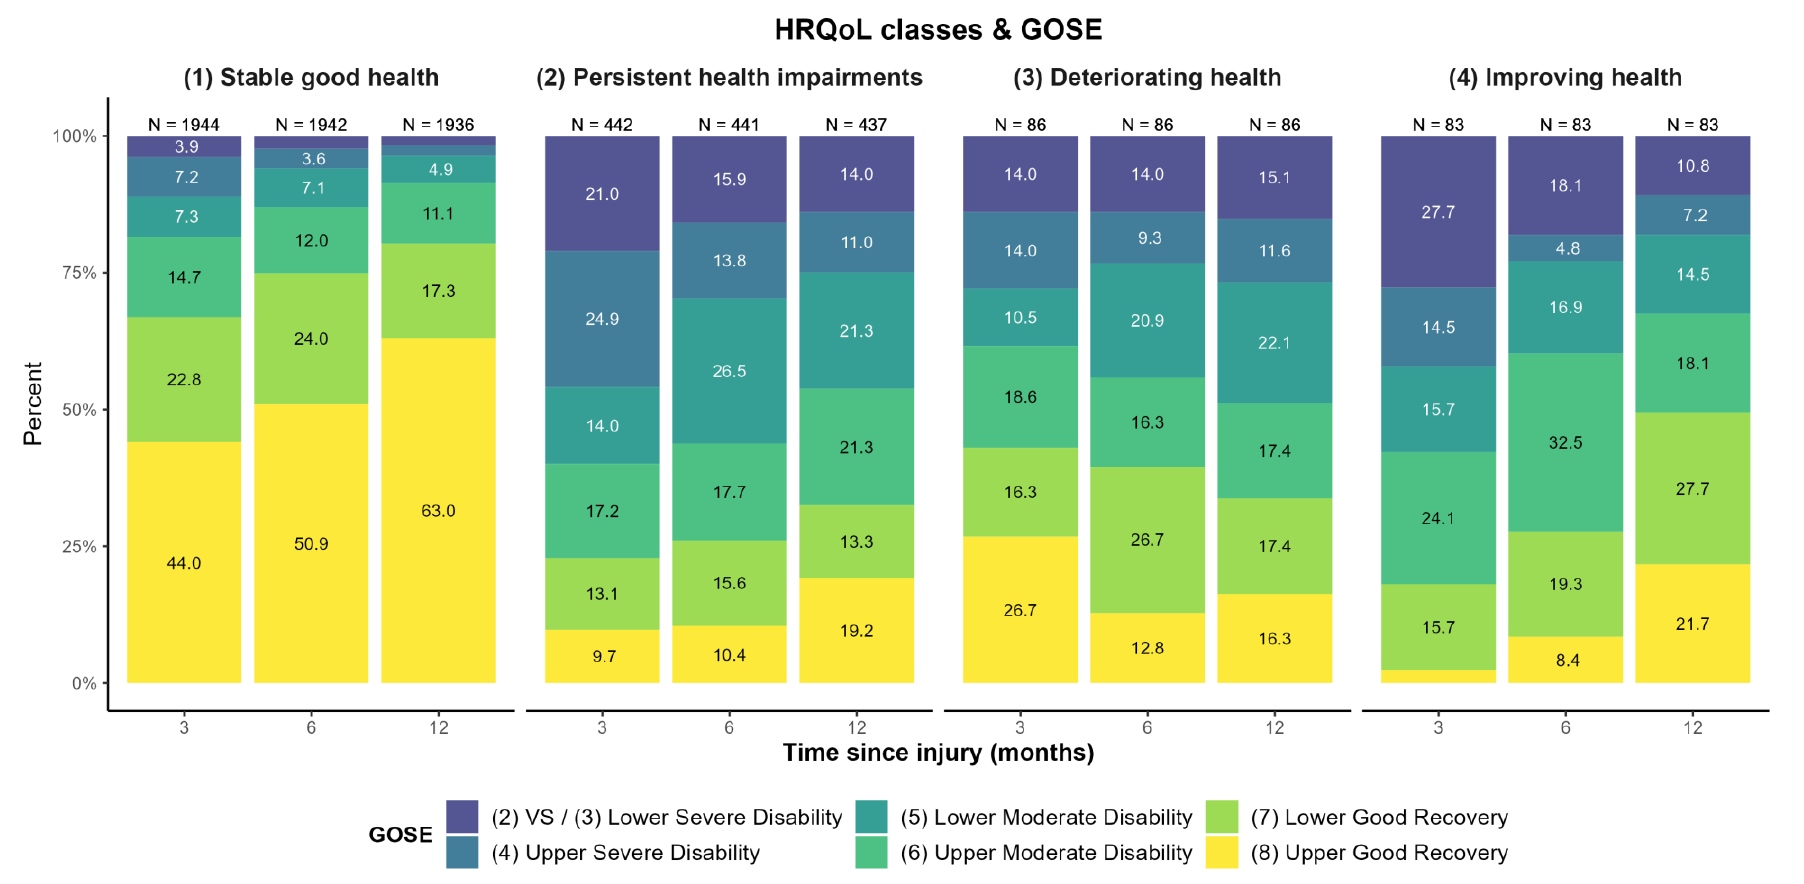
Figure 4. GOSE-levels at three, six, and twelve months after TBI for each generic and disease-specific HRQoL trajectory class. Decreasing sample sizes due to death of participants. Percentages < 3% not displayed.